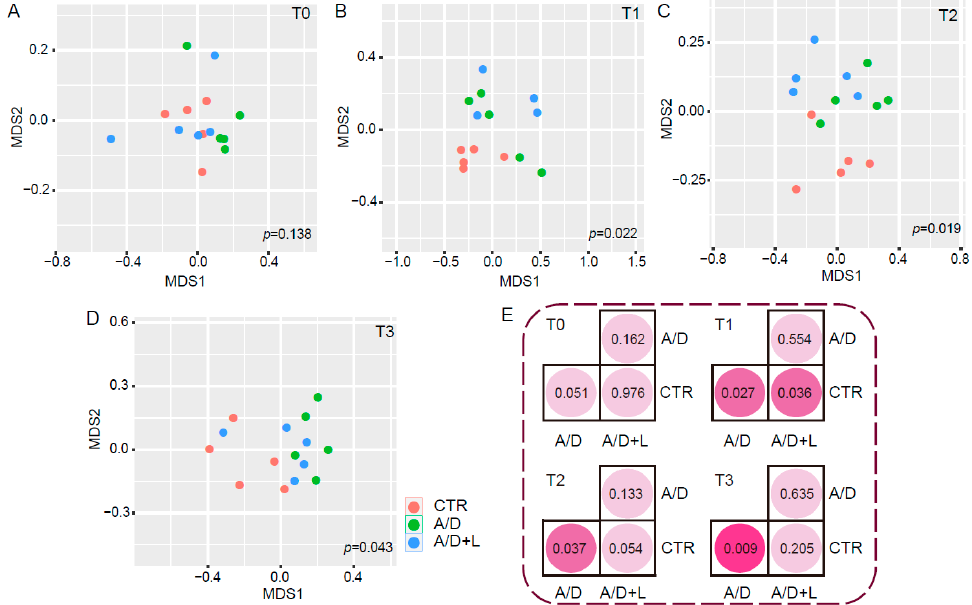
Figure 5. Effect of lactulose on the composition of the fecal microbiota in the AOM/DSS model. The scatter diagrams according to the feature values of MDS1 and MDS2 obtained after dimension reduction are shown for the control (CTR), AOM/DSS (A/D), and AOM/DSS + lactulose (A/D+L) groups ( n = 5) at time points, T0 (A), T1 (B), T2 (C), and T3 (D). NMDS analysis based on Bray ‒ Curtis distances revealed the feature values of each sample. The p -values were calculated among three groups (a–d) and between two groups via ANOSIM test (E).